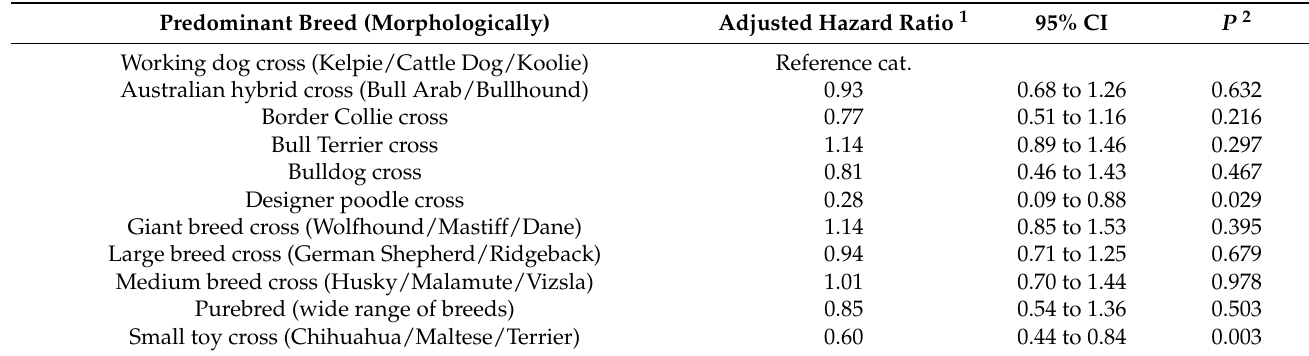
Table 4. Adjusted hazard ratio estimates for the association between breed and time-to-readmission to RSPCA Queensland for dogs adopted from RSPCA Queensland in 2019 and 2020. Breed rather than bodyweight was used in this